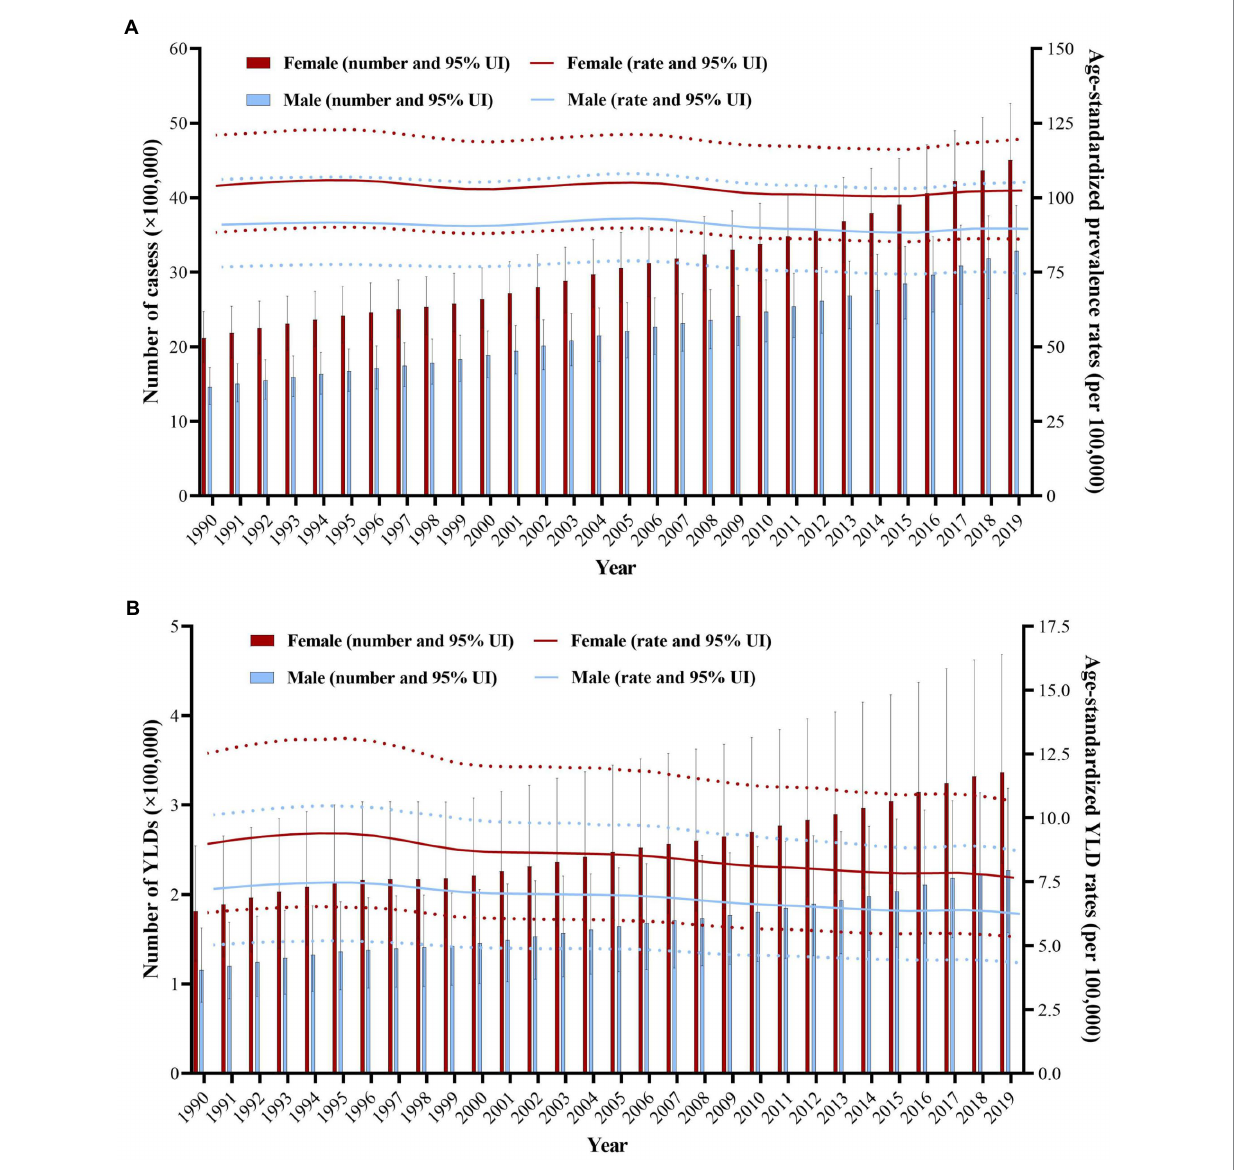
FIGURE 1 Changes in global burden of the prevalence and YLDs of AMD from 1990 to 2019. (A) The number of cases and age-standardized prevalence rates of AMD from 1990 to 2019. (B) The number of YLDs and age-standardized YLD rates of AMD from 1990 to 2019. Red and blue dashed line indicates the upper and lower limits of the 95% uncertainty intervals (95% UIs) for females and males, respectively. AMD, age-related macular degeneration; UI, uncertainty interval; YLDs, years lived with